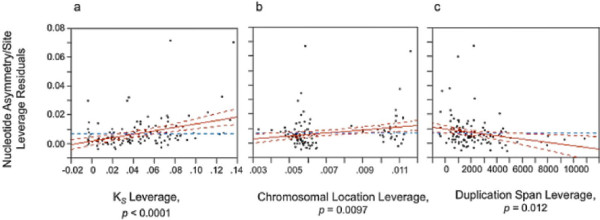
Partial regression leverage plots from a stepwise regression analysis detailing the contribution of three significant predictors to standardized nucleotide asymmetry between paralogs comprising 130 C. elegans duplicate pairs. The vertical axis represents the partial residuals of standardized nucleotide asymmetry (y variable) and the horizontal axis represents the partial residual of the specific predictor variable. Dashed red lines represent 95% confidence curves for the full model (solid red line) based on actual data. The dashed blue horizontal line indicates a model with no effect. Confidence curves enclosing a solid red line deviating significantly from the dashed blue horizontal line indicate a significant effect of the predictor variable. Alternatively, when the confidence curves enclose the dashed blue horizontal line, the effect of the predictor variable is nonsignificant. (a) Partial regression leverage plot showing a significant positive effect of evolutionary age of duplicates (KS) on nucleotide rate asymmetry between paralogs. (b) Partial regression leverage plot showing a significant positive effect of chromosomal location on nucleotide rate asymmetry between paralogs. Rate asymmetry between paralogs increases with relocation of one copy to a different chromosome. (c) Partial regression leverage plot showing a significant negative effect of duplication span on nucleotide rate asymmetry between paralogs.